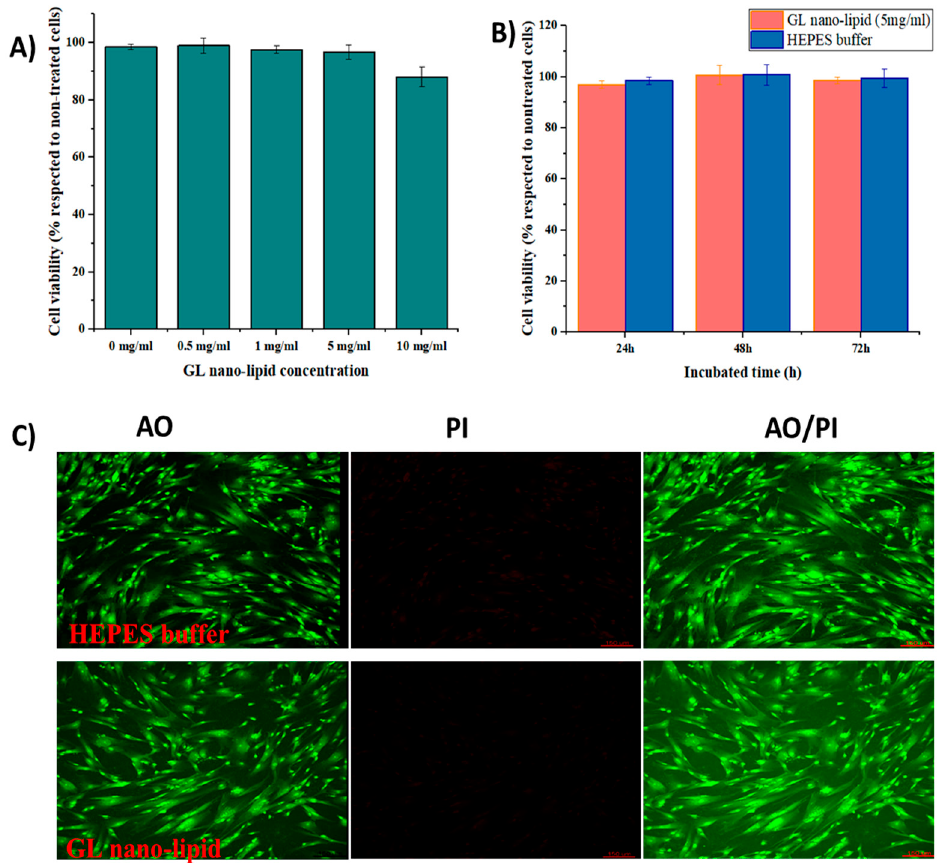
Figure 5. ( A ) The cytotoxicity of MSCs treated with different GL nano-lipid concentrations (0 mg/mL, 0.5 mg/mL, 1 mg/mL, 5 mg/mL and 10 mg/mL) in respected to non-treated MSCs. ( B ) The cytotoxicity of MSCs in function of time when incubated with 5 mg/mL GL nano-lipid and HEPES buffer. Results are presented as mean ± standard deviation (n = 3). ( C ) Con-focal microscopy images of MSCs up to 72 h incubation at 37 ◦ C with GL nano-lipid (5 mg/mL) and HEPES buffer. AO: green color; PI: Red color; AO/PI: Merged color; Scale bar = 150 μ m.